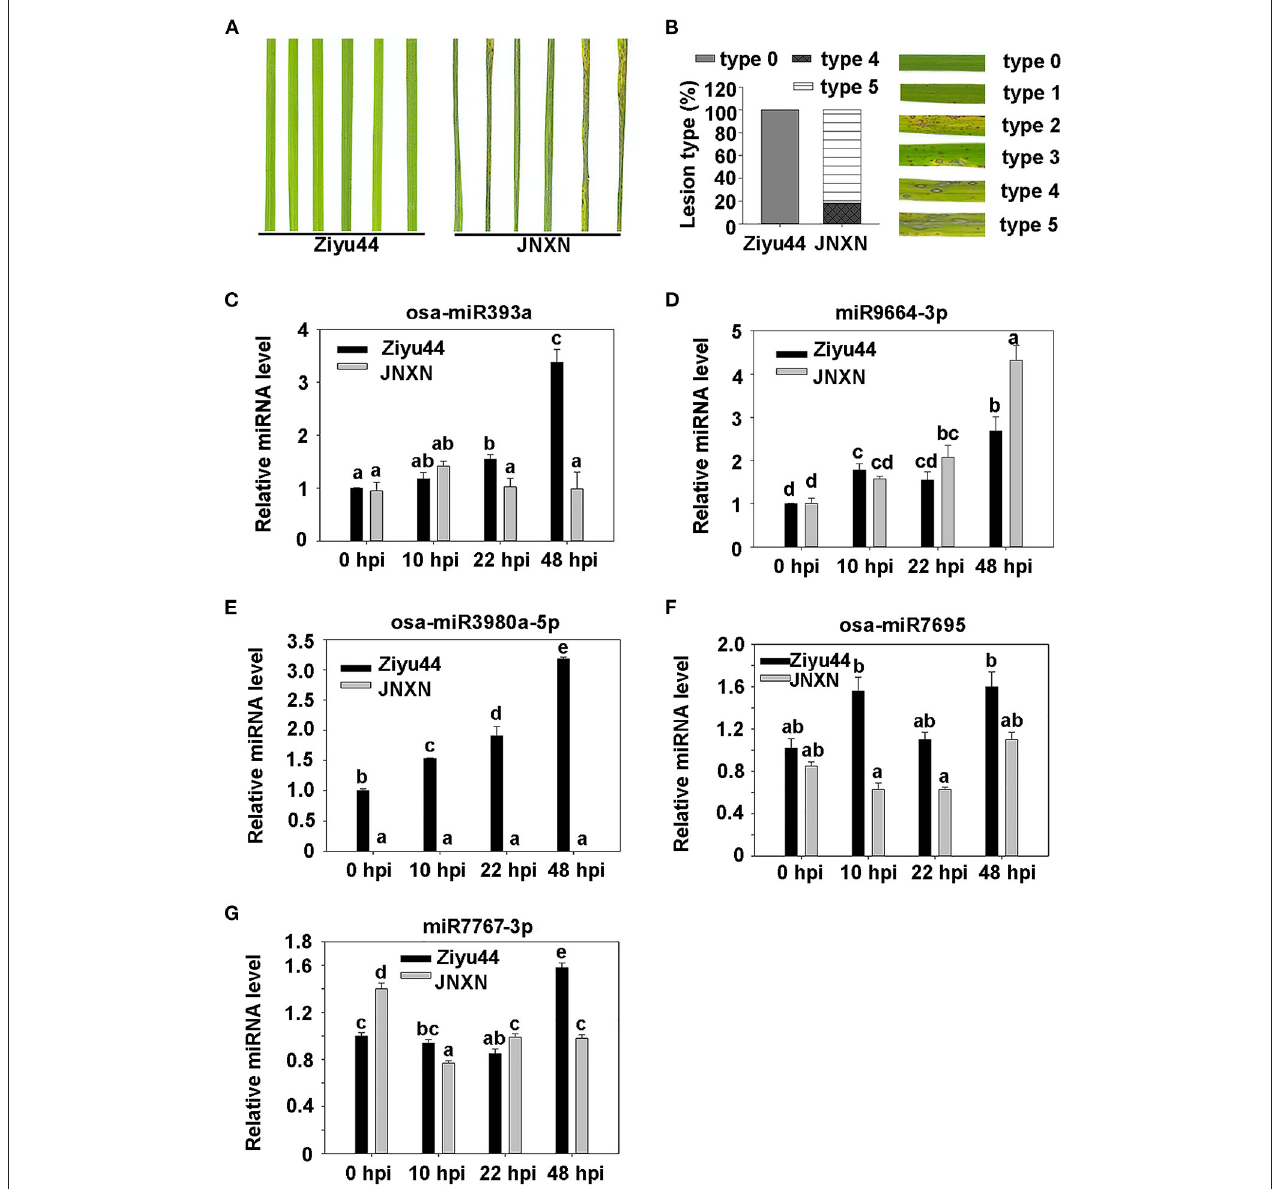
FIGURE 3 | Validation of some significantly differentially expressed miRNAs by RT-qPCR. (A) The phenotype of the leaf sections from the resistant accession Ziyu44 and susceptible accession JNXN inoculated with M. oryzae at 5 dpi. (B) The representative phenotype of lesion types, and the percentage of the Ziyu44 and JNXN lesion types. (C–G) Expression pattern of osa-miR393a (C) , miR9664 (D) , osa-miR3980a-5p (E) , osa-miR7695 (F) , and miR7767-3p (G) in Ziyu44 and JNXN after being infected with M. oryzae . miRNA level is normalized to that in the untreated control plants (0 hpi). Error bars indicate SD ( n = 3). The letters above the bars indicate significant differences at a value of P < 0.01 as determined by a one-way ANOVA followed by a post-hoc Tukey HSD analysis. Similar results were obtained from the three independent